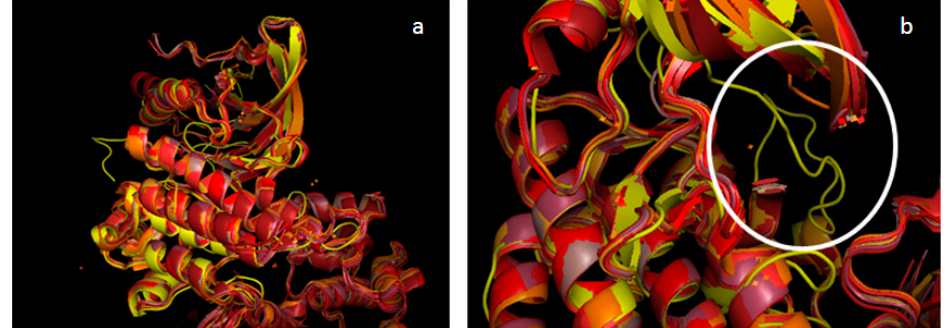
Figure 1. Alignment of all Mer structures from PDB with our Mer DFG-Asp in model. PDB structure of Mer in different shades of red (PDB ID 2P0C in dark salmon ; PDB ID 3BPR in TV red ; PDB ID 3BRB in firebrick ; PDB ID 3TCP in raspberry ; PDB ID 4M3Q in orange , PDB ID 4MH7 in bright orange ; PDB ID 4MHA in red ); our Mer DFG-Asp in model, in yellow (all colors from PyMOL). ( a ) Superimposition of reported Mer crystal structures with our Mer DFG-Asp in model. ( b ) Zoom on the activation loop (circled in white) found only